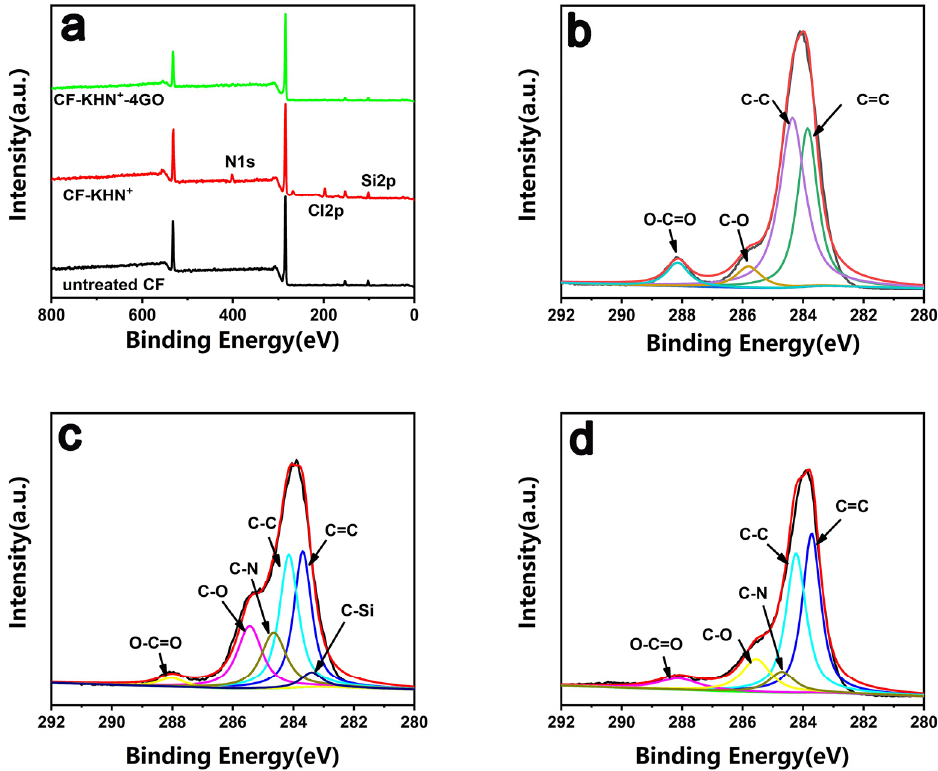
Figure 5. XPS full spectra of carbon fibers ( a ) and XPS curve fitting of carbon fibers. ( b ) Untreated CF, ( c ) CF-KHN + , ( d ) CF-KHN + -4GO. ( c ) CF-KHN + , ( d ) CF-KHN +